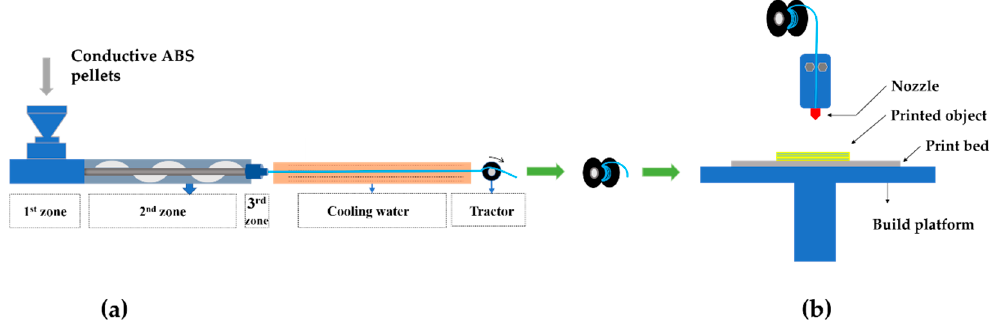
Figure 1. ( a ) Preparation of the conductive ABS filaments. ( b ) 3D printing process.